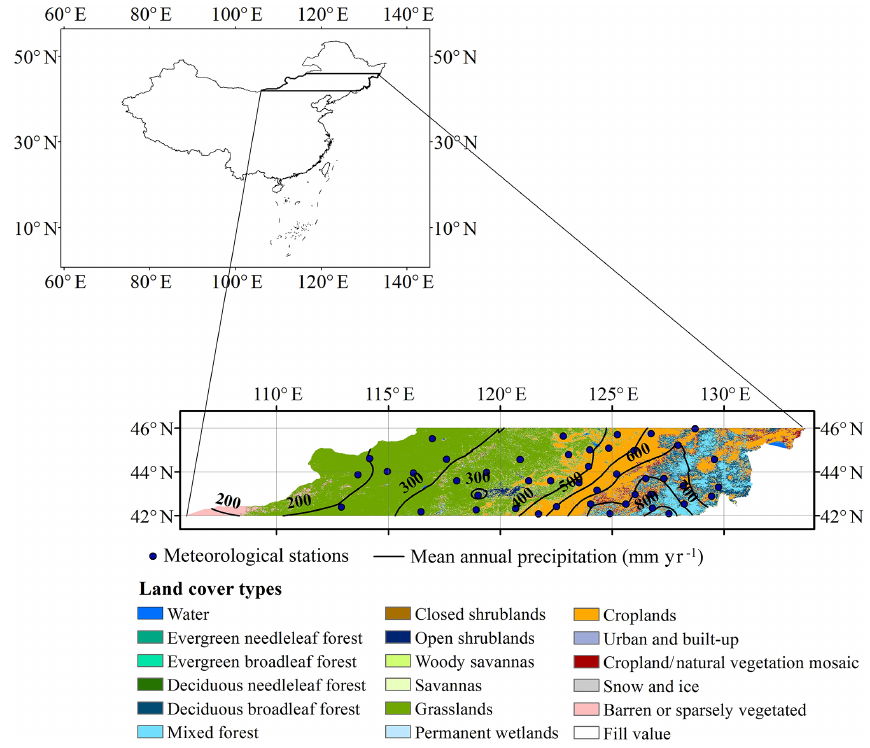
Figure 1. The geographic location, land cover, spatial distribution of precipitation and meteorological station locations of the NECT.